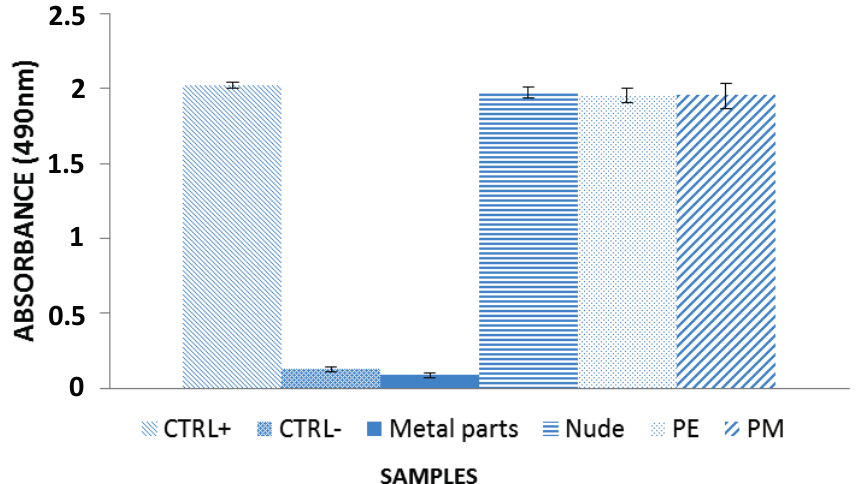
Figure 3. Cells viability evaluated with MTT assay. “Nude”, “PE” and “PM” stand respectively for “non-encapsulated”, “polyester-encapsulated” and “polymide-encapsulated” sensors. HACAT cells were incubated overnight in medium pre-incubated with: the metal parts, no-encapsulated (“nude”) sensor, polyester (“PE”) and polyimide (“PM”) encapsulated sensors. CTRL-; negative control, cells incubated with 1% triton-X100. CTRL+; positive control; cells grown in fresh DMEM. Results are indicated as means ± SD of three different